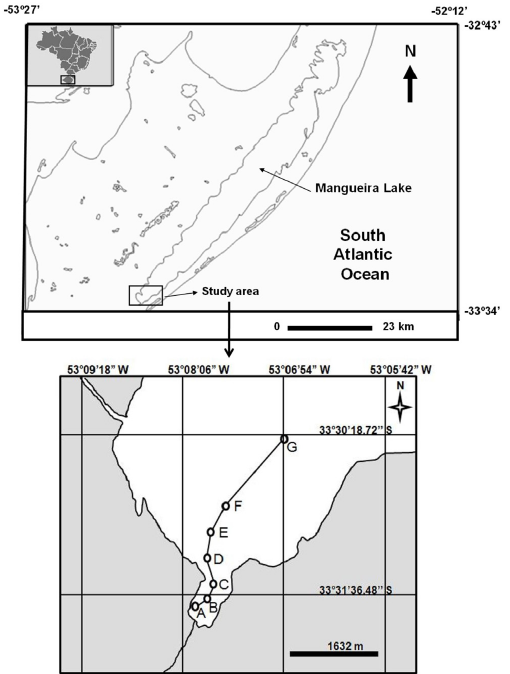
Figure 1. Lake Mangueira (southern end), a coastal large lake in Rio Grande do Sul state, Brazil. Part of transect sampled running from a densely vegetated littoral zone (stations A-C) to a phytoplankton dominated pelagic zone without macrophytes (stations D-G). Total length: ~3.2